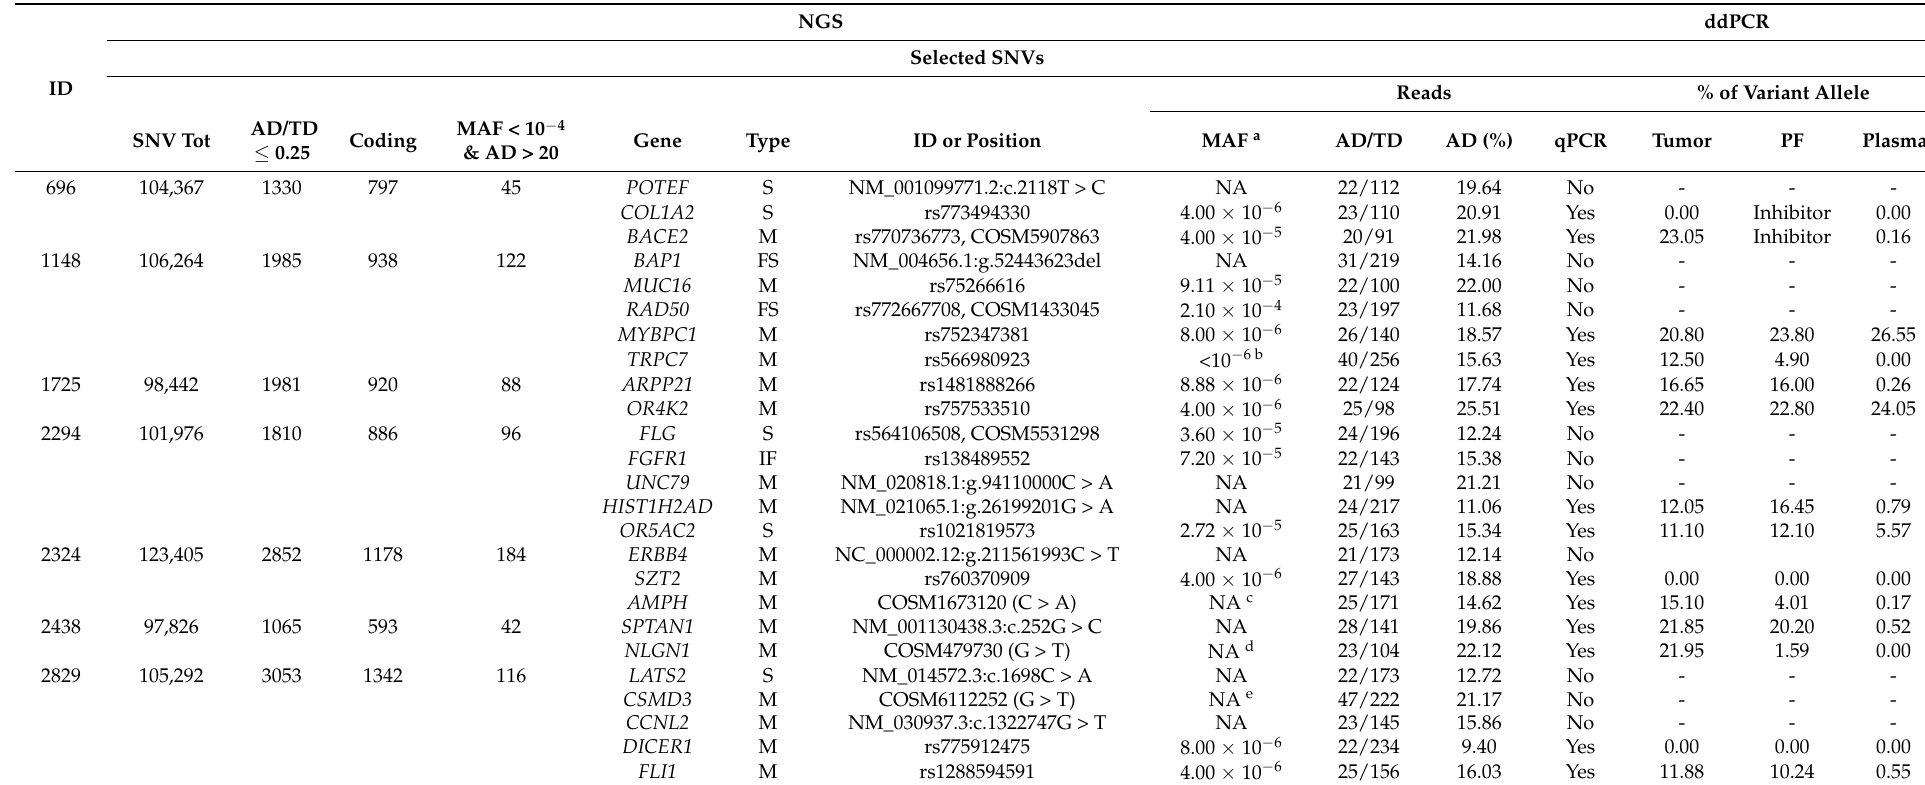
Table 1. Selected mutations analyzed for Group GE after FGE filtering and relative ASO–qPCR and ddPCR